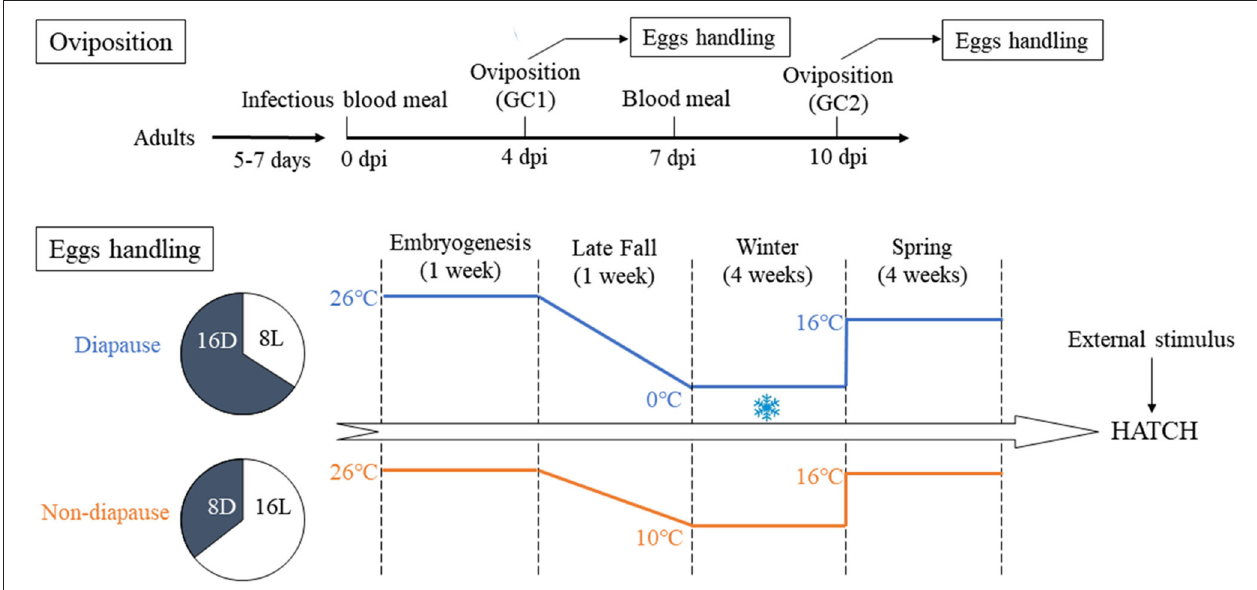
FIGURE 1 | Illustration of the experimental design in the context of oviposition and eggs handling. GC1, first gonotrophic cycle; GC2, second gonotrophic